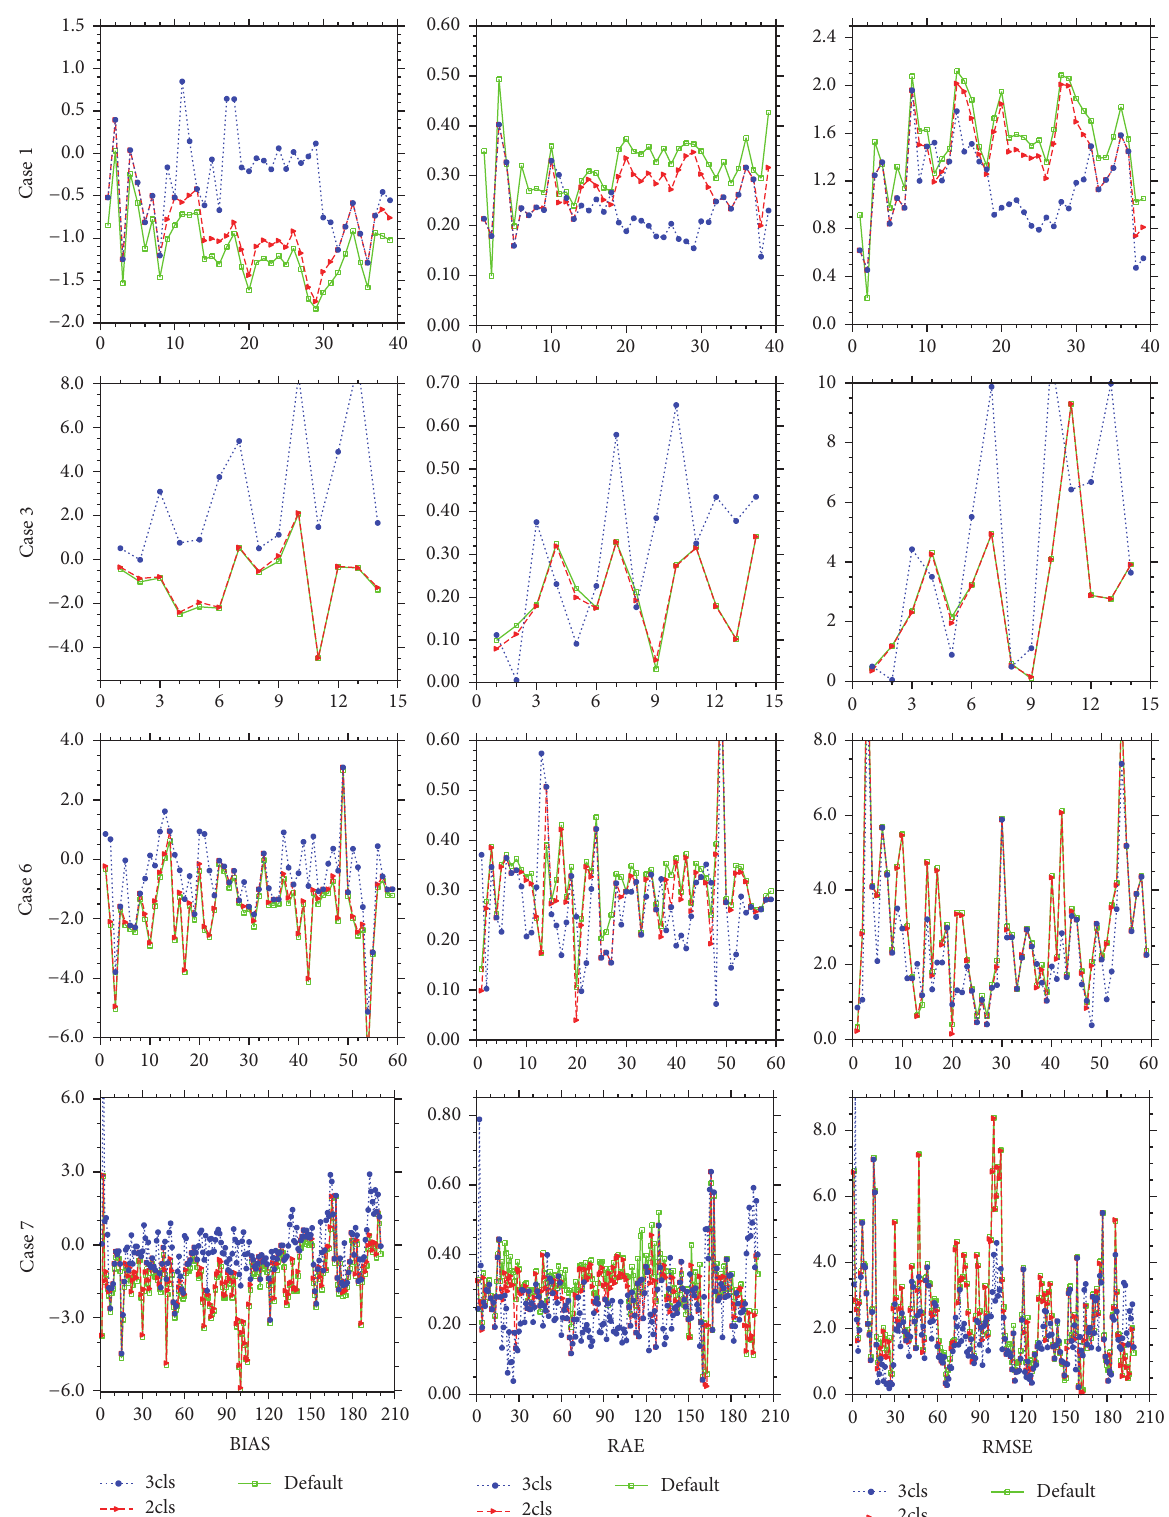
Figure 5: Hourly errors for all stations. Cases 1, 3, 6, and 7. The abscissas represent rainfall duration (unit: